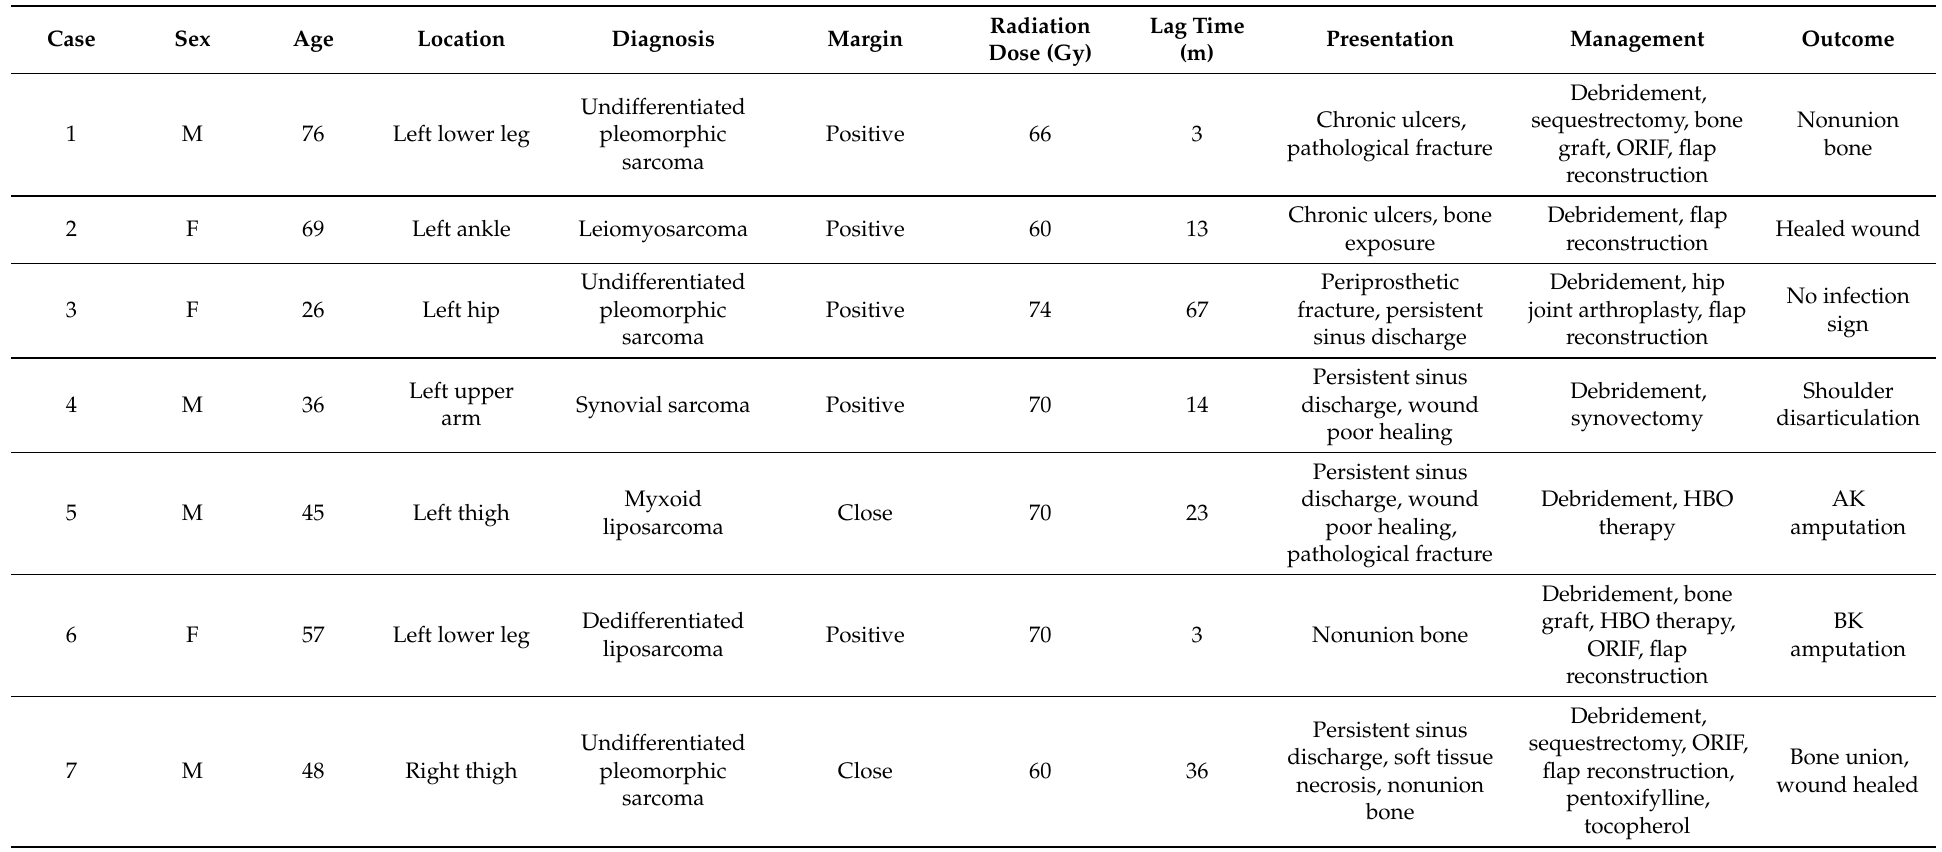
Table 2. Characteristics of patients with extremity